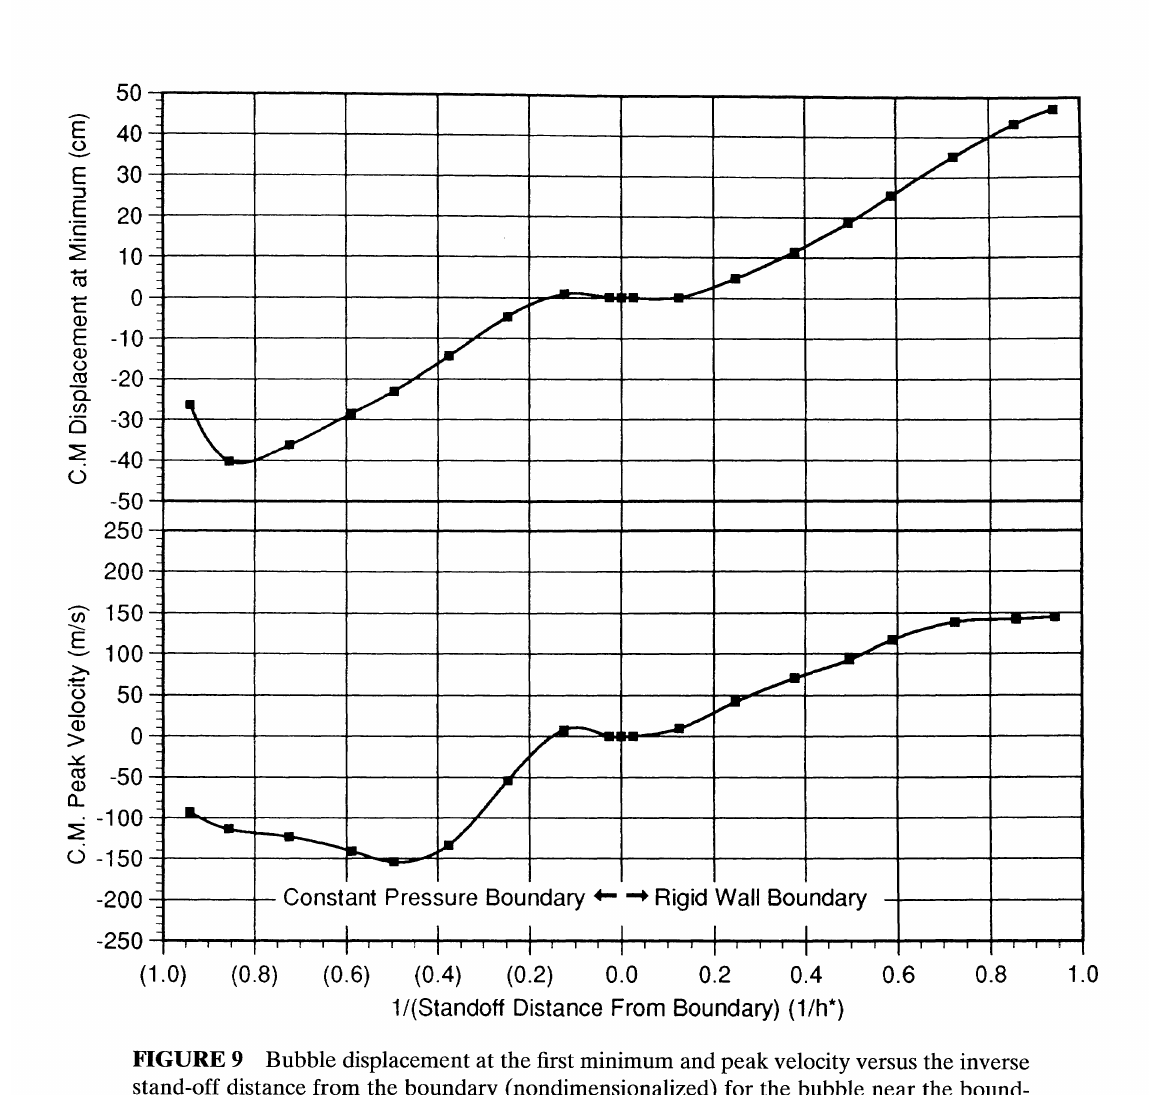
FIGURE 9 Bubble displacement at the first minimum and peak velocity versus the inverse stand-off distance from the boundary (nondimensionalized) for the bubble near the bound ary